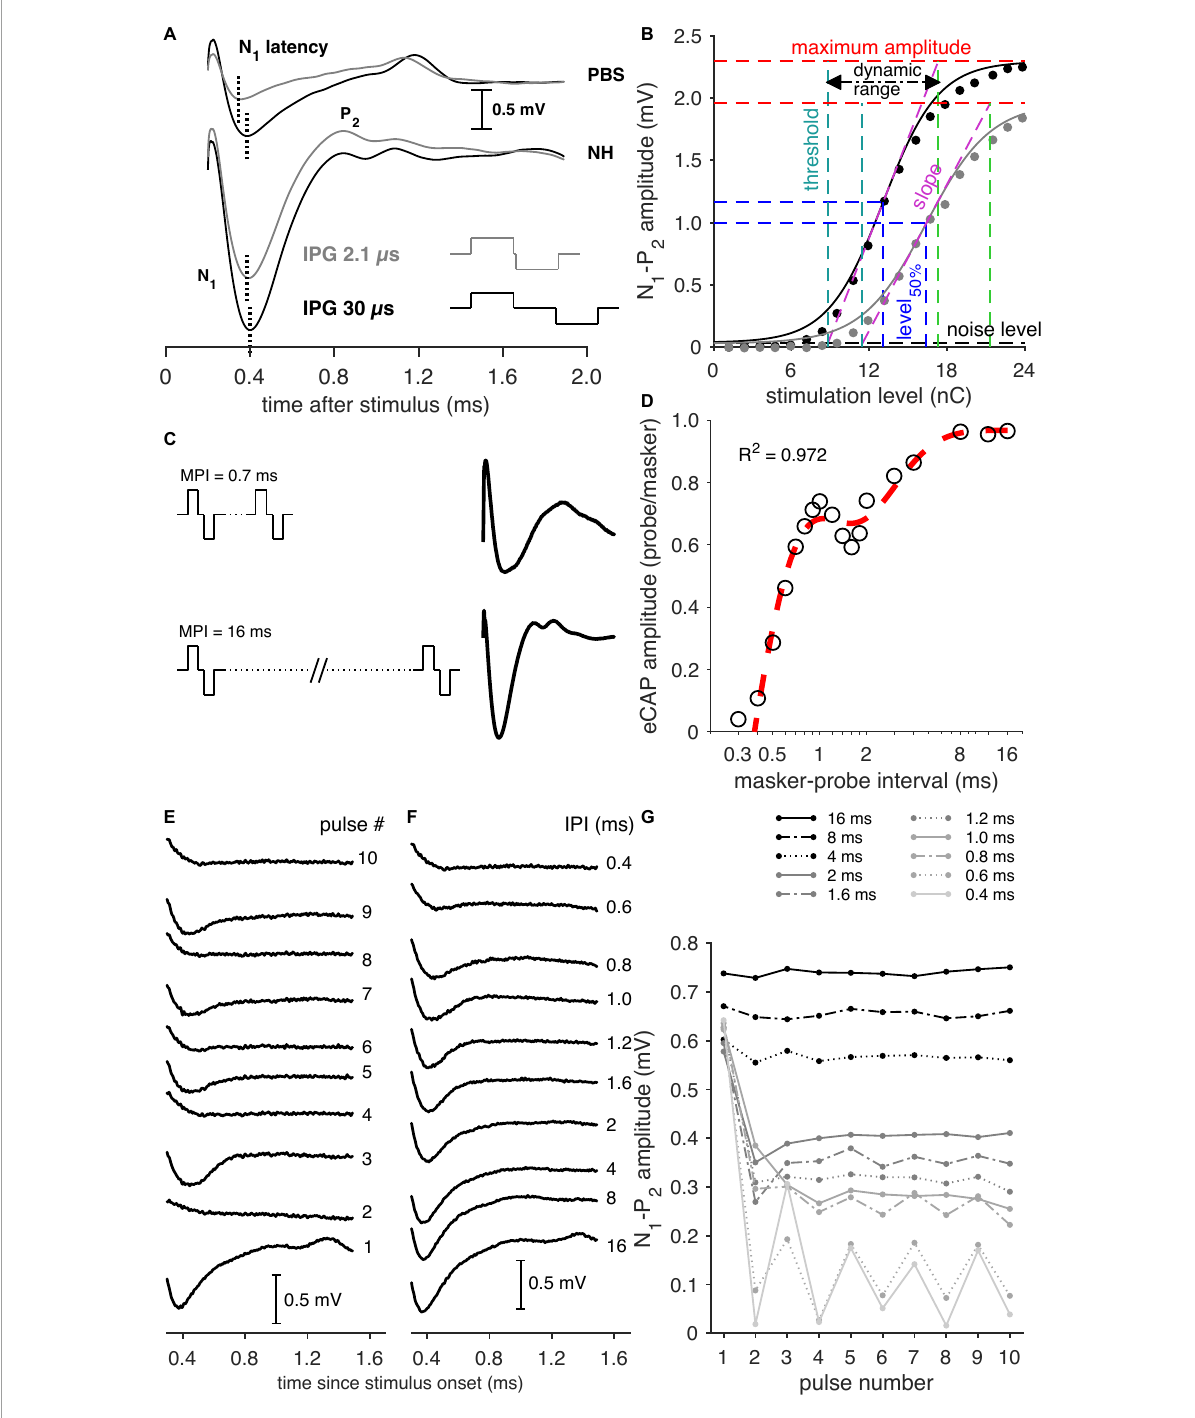
FIGURE1 Examples of the various eCAP recording paradigms. (A) Examples of eCAPs from a PBS animal (top) and a normal-hearing (NH) animal (bottom) for both an IPG of 2.1 and 30 µ s (pulse shapes illustrated in the lower right corner), with the indication of the N 1 latency. (B) Input–output curves of an NH animal for an IPG of 2.1 (gray markers) and 30 µ s (black markers), with corresponding sigmoid fitting (solid lines) and the derived eCAP measures. (C) Examples of eCAP recordings following a short (0.7 ms) masker-probe interval (MPI) and the longest (16 ms) MPI from a normal-hearing animal. (D) Example of an eCAP amplitude recovery function from an NH animal including the double exponential fit (red trace). (E) eCAP recordings from a Cocktail animal to the first ten pulses of a pulse train with an inter-pulse interval (IPI) of 0.6 ms. Note the alternating pattern in the eCAP waveform, with higher amplitudes following odd-numbered pulses and lower amplitudes following even-numbered pulses. (F) Examples of eCAPs evoked by the tenth pulse at each IPI used in the pulse-train paradigm. Note the gradual decrease of eCAP amplitude and increase of N 1 latency with shorter IPIs. (G) The eCAP N 1 -P 2 amplitudes in response to each of ten pulses for every IPI (0.4–16